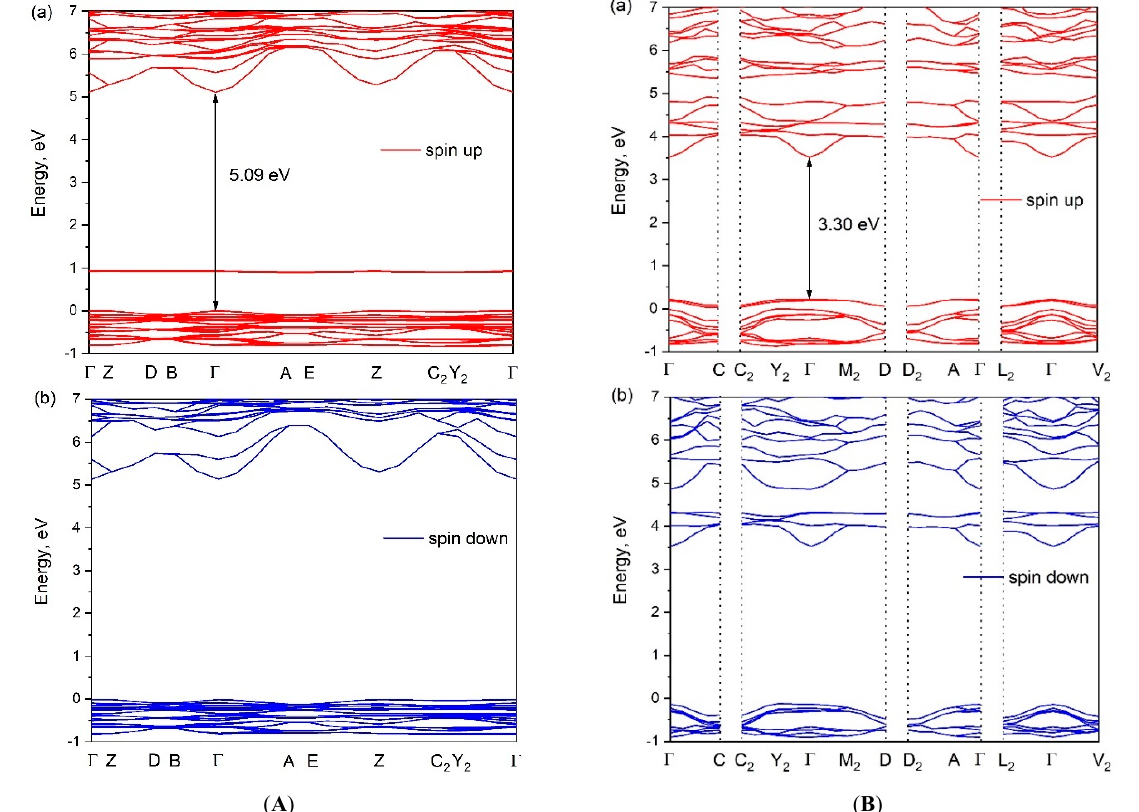
Figure 9. The electronic band structures of ( A ) [CsEu(H 2 O) 3 (SO 4 ) 2 ]·H 2 O and ( B ) CsEu(SO 4 ) 2 . The partial density of states (PDOS) for [CsEu(H 2 O) 3 (SO 4 ) 2 ]·H 2 O and CsEu(SO 4 ) 2 are shown in Figure 10 and the contribution of each type of atoms can be considered. It can be stated that the valence band top in both compounds was governed by the p electrons of oxy- gen, while the conduction band bottom was formed by the d electrons of Eu 3+ ions. The small peak related to the f-electron state of Eu 3+ ions appeared near the Fermi level in both cases.